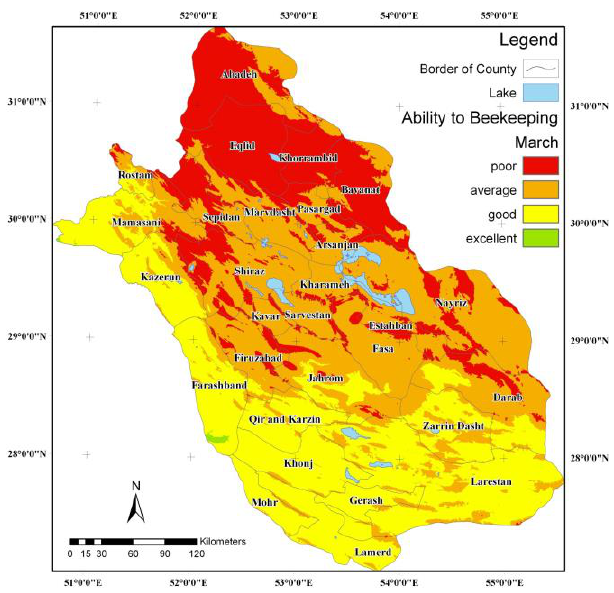
Fig. 12. Suitability of climate conditions for beekeeping in